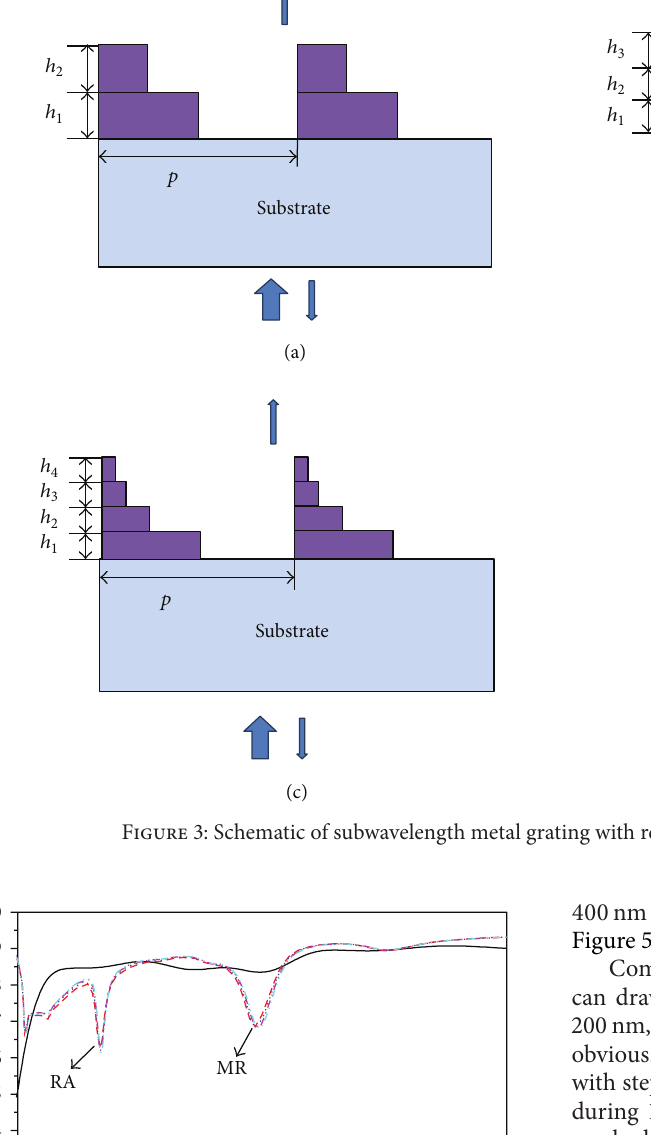
depths are 100 nm, 200 nm, 300 nm, and 400 nm, and step numbers are from one to four corresponding duty cycles as above mentioned, and the incident wavelength is